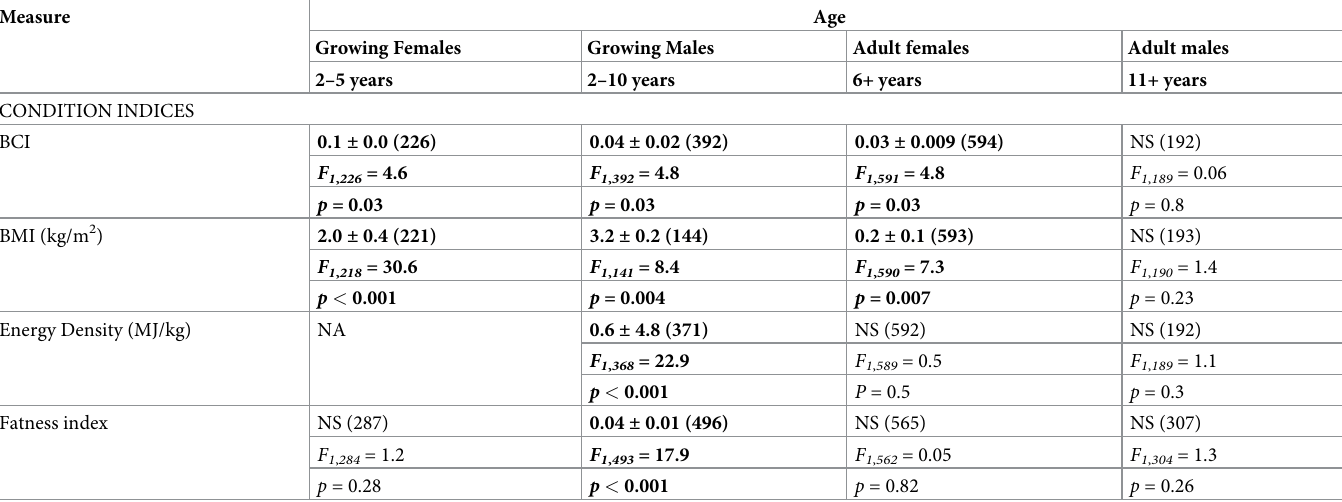
Table 3. Results of models examining whether condition indices are related to age for polar bears in four sex/age categories.